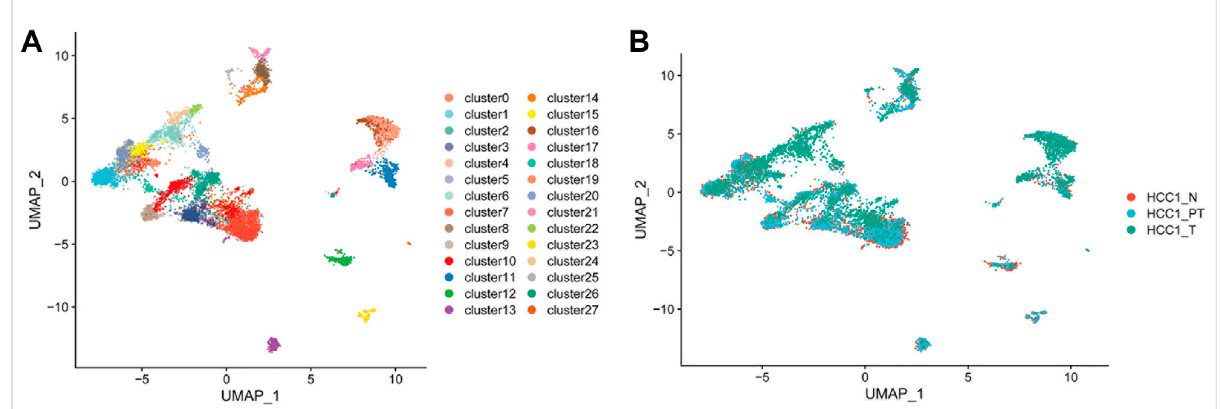
FIGURE 1 DissectionofHCCpatienttissueheterogeneitybyscRNA-seq. (A) Totalof12,784singlecellsand28cellclusterswereidenti fi edandshownwith UMAP; and (B) distribution of cells in different samples (N, distal liver tissue; PT, proximal liver cancer tissue; T, liver cancer tissue.)